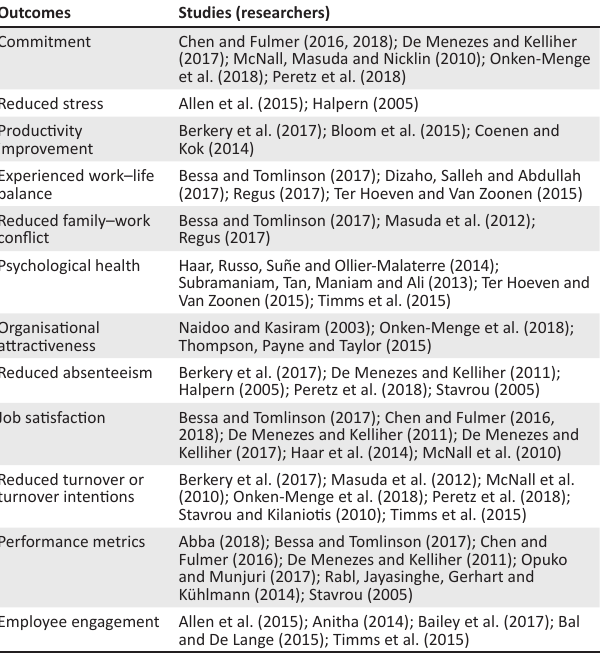
TABLE 1: Benefits of flexible work arrangements. Outcomes Studies (researchers)